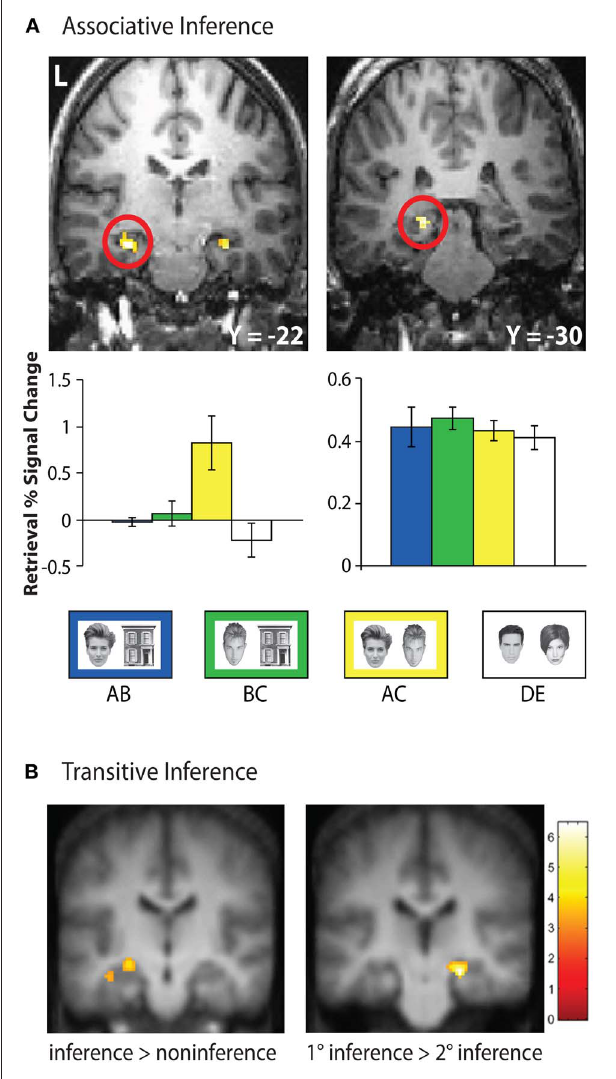
FIGURE 4 | Hippocampal retrieval activation during inferential reasoning tasks. (A) Bilateral anterior hippocampus demonstrated selective activation during novel inferential probe trials (AC) at retrieval in an associative inference task. In contrast, a posterior region of the hippocampus demonstrated equivalent activation during associative retrieval of overlapping trained associations (AB, BC), non-overlapping trained associations (DE), and inferential probe trials. Adapted by permission from Preston et al. (2004), copyright 2004 Wiley-Liss, INC. (B) During transitive inference, left hippocampal activation demonstrated greater retrieval activation for novel inference trials relative to non-inference trials, while right hippocampus showed increased activation during inference trials in which items were separated by one element in the hierarchy (1 ◦ ) compared with items separated by two hierarchical elements (2 ◦ ). Adapted by permission from Zalesak and Heckers (2009), copyright 2009